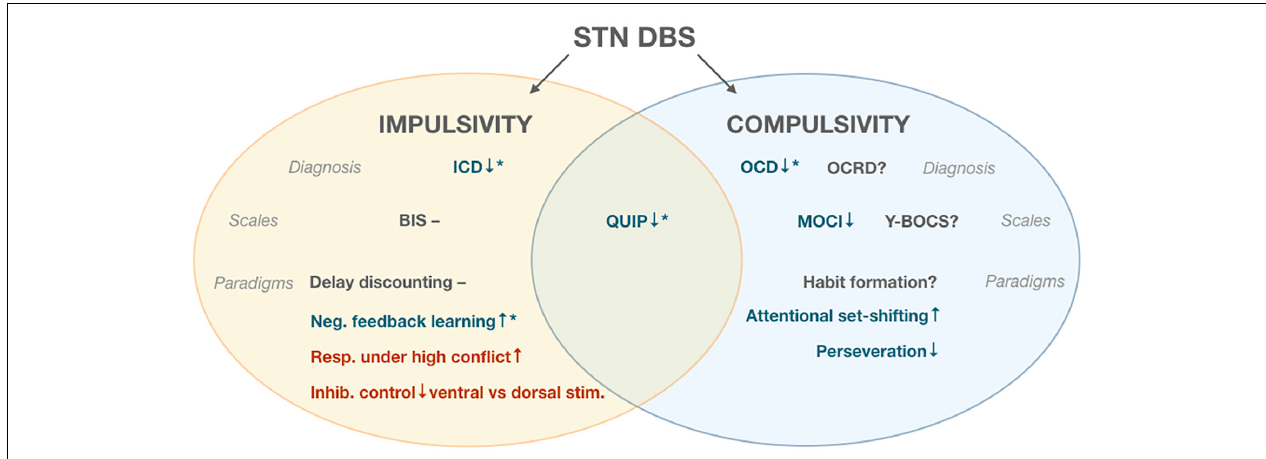
FIGURE 1 | Effects of Subthalamic Deep Brain Stimulation (STN DBS). ↑ denotes increase in measured parameter, ↓ denotes decrease, and – denotes no change. (cid:4) indicates improvement, (cid:4) indicates impairment * post-surgical decrease in levodopa equivalent daily dose (LEDD), ? indicates measure unreported in literature. Impulse Control Disorders (ICD), Obsessive Compulsive Disorder (OCD), Obsessive Compulsvie Related Disorders (OCRD), Barrat Impulsiveness Scale (BIS), Questionnaire for Impulsive-Compulsive Disorders (QUIP), Maudsley Obsessional-compulsive inventory (MOCI), Yale-Brown Obsessive Compulsive Scale (Y-BOCS).